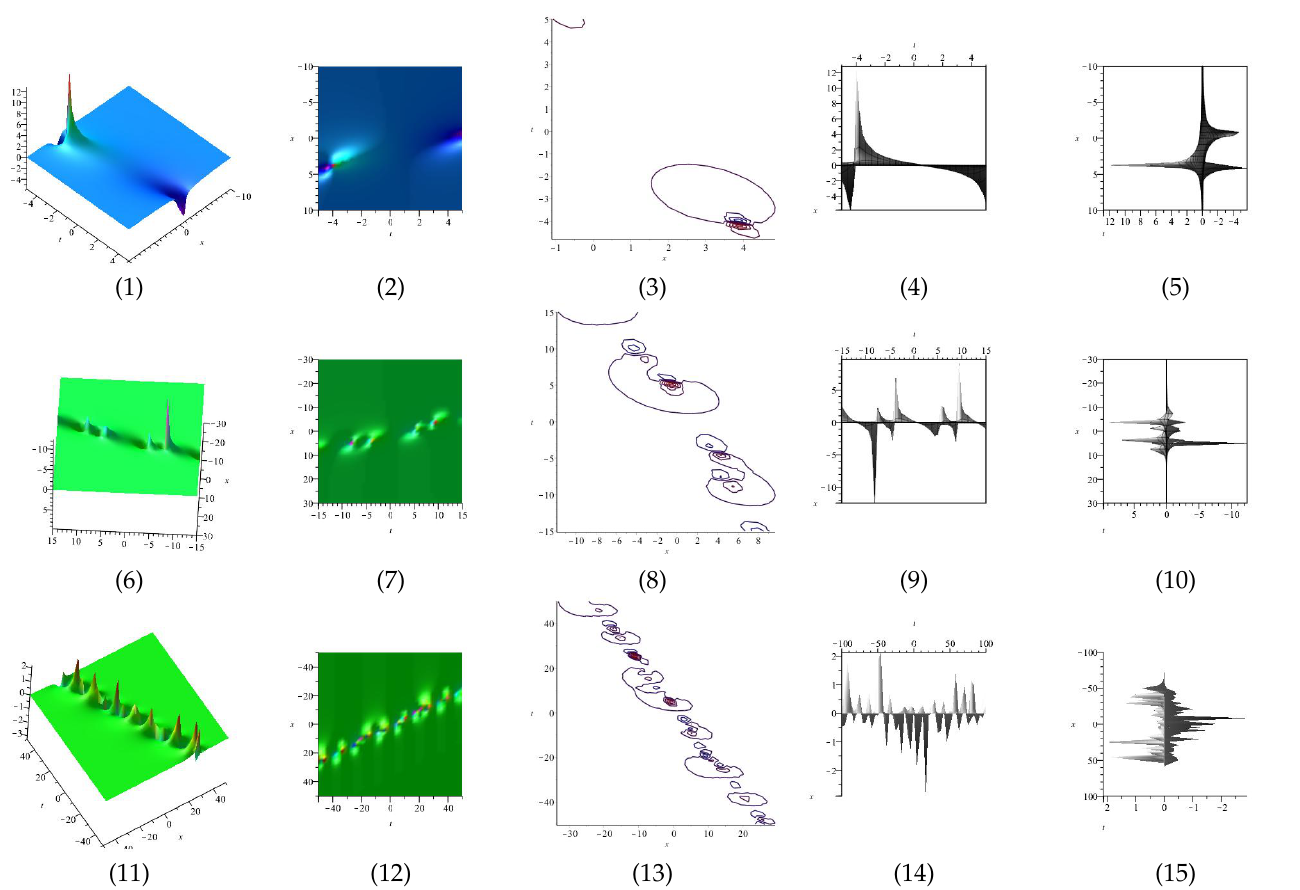
Figure 16. The 3D and 2D with the diagram of the imaginary part of equation u 3,2 , in three differ- ent domains, for S 1 = 0.20, S 2 = 0.70, S 3 = − 0.50. ( 2 ) , ( 7 ) , ( 12 ) , ( 4 ) , ( 9 ) , ( 14 ) , and ( 5 ) , ( 10 ) , ( 15 ) display z − axis, x − axis and y − axis orientations, respectively, and ( 3 ) , ( 8 ) , ( 13 ) are contour plots, in different